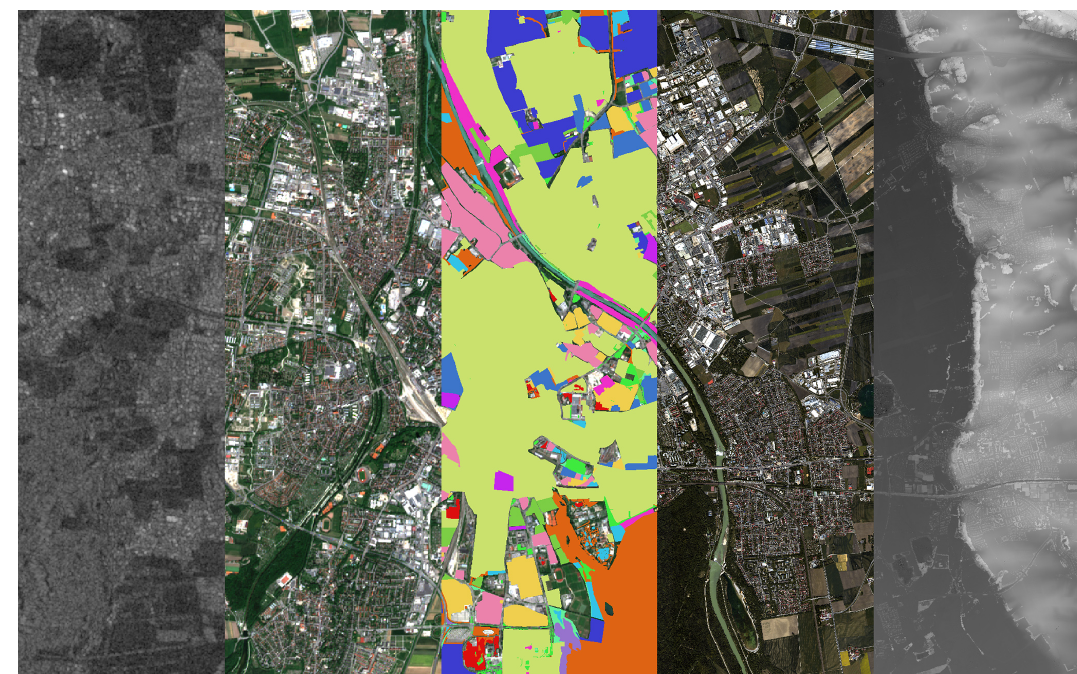
Figure 1. The visualization of five data modalities in MDAS. From left to right: the Sentinel-1 image (VH band in dB), the Sentinel-2 image (RGB: 665, 560, 490nm), the OSM land use layer, the HySpex image (RGB: 691, 569, 445nm), and the